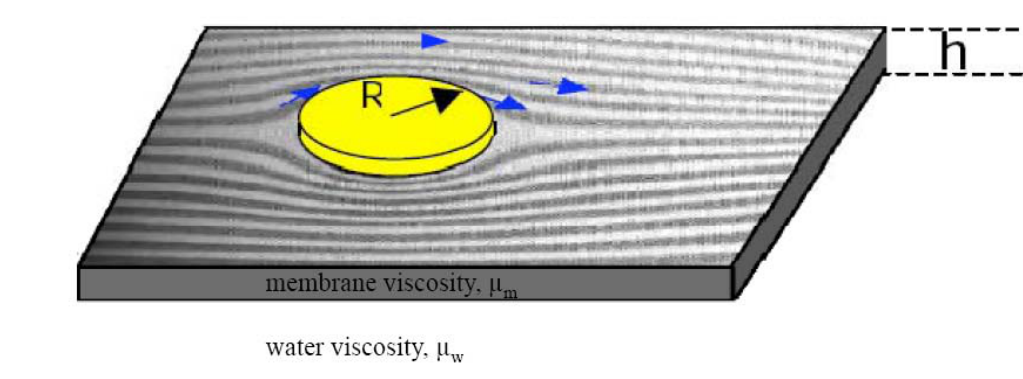
Figure 1. A schematic representation of an object diffusing inside a liquid membrane (after Figure 1 from Saffman and Delbrück